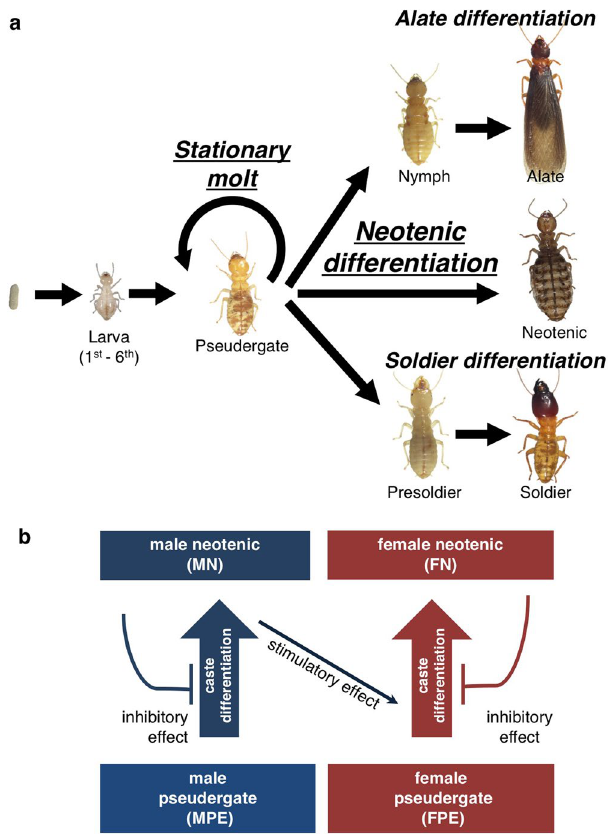
Figure 1. ( a ) Caste developmental pathways in the damp-wood termite Hodotermopsis sjostedti . Each arrow indicates a molting event. The neotenic differentiation occurs from pseudergate via a single molt. Most pseudergates undergo a molt into the pseudergate stage termed “stationary molt.” ( b ) Diagram showing the regulation of neotenic differentiation by social interactions, previously shown in H. sjostedti 15 . The neotenic differentiation is suppressed by the presence of neotenics of same sex. In the absence of female neotenics, male neotenics promoted the differentiation of female